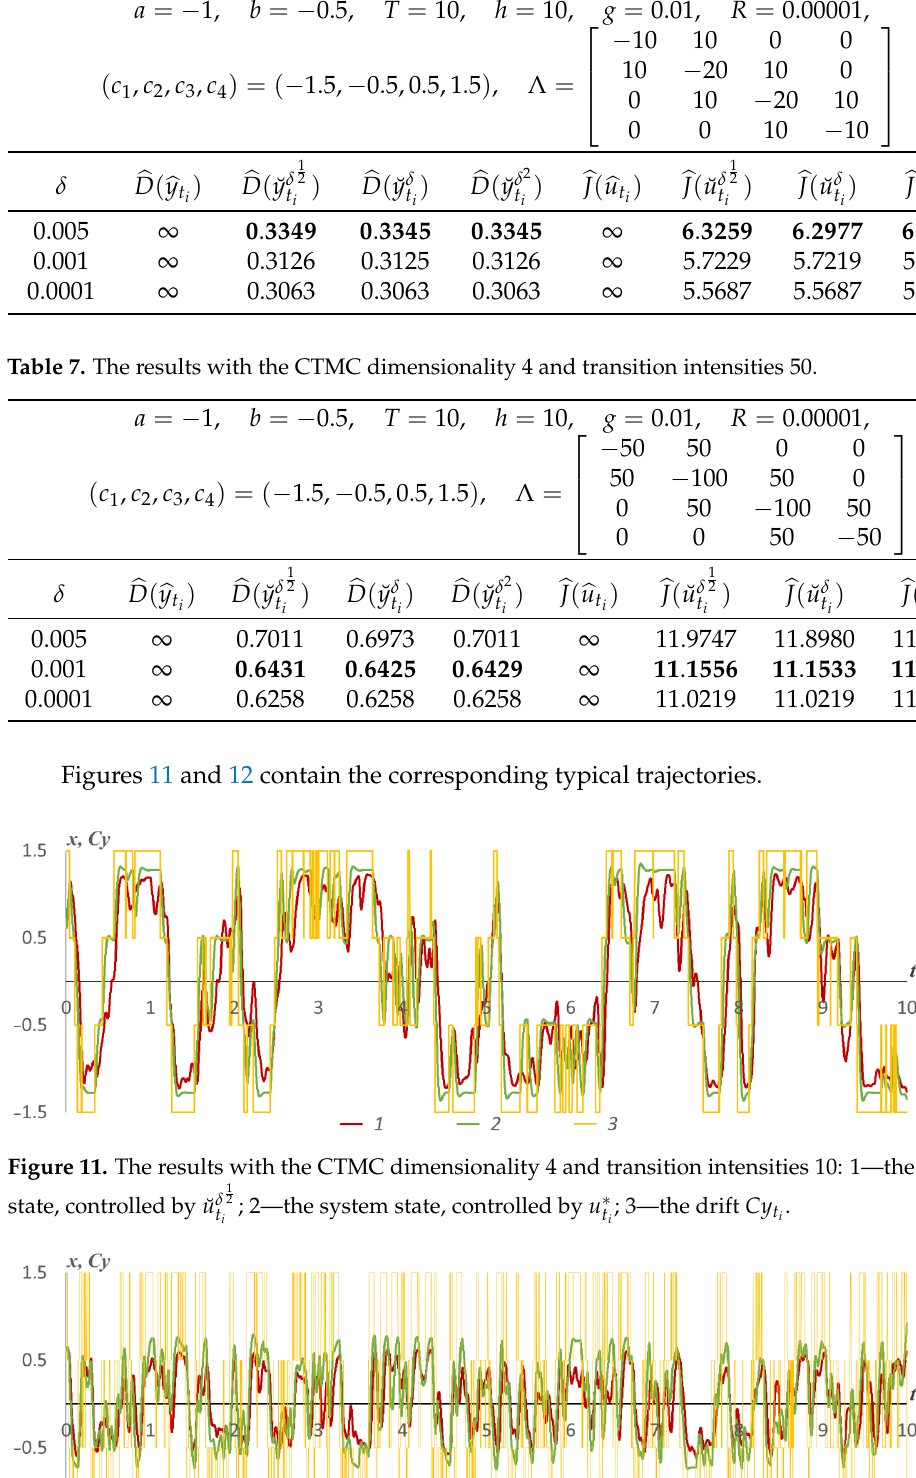
Figure 12. The results with the CTMC dimensionality 4 and transition intensities 10: 1—the system state, controlled by ˘ u δ